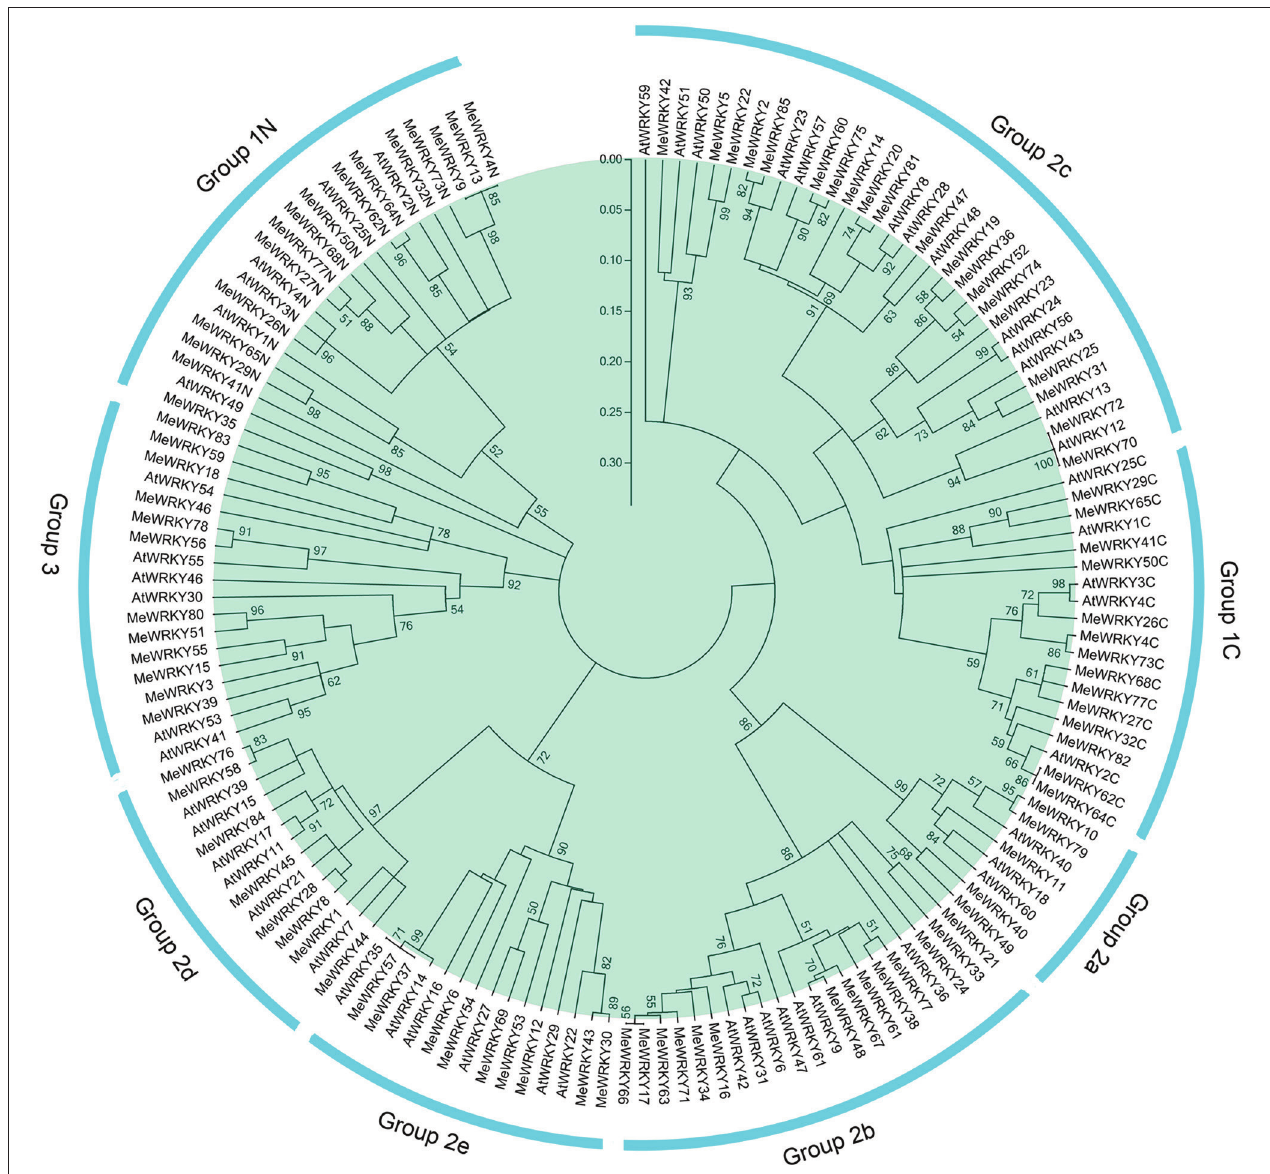
FIGURE 1 | Phylogenetic analysis of WRKY proteins from cassava and Arabidopsis. The NJ tree was constructed with WRKY domains of WRKYs from cassava and Arabidopsis using ClustalX 2.0 and MEGA5 with 1000 bootstrap. Branches with less than 50% bootstrap support were collapsed. The WRKY proteins are grouped into three groups (1–3) and five subgroups (2a–2e). Group 1 proteins with the suffix “N” or “C” indicates the N-terminal WRKY domains or the C-terminal WRKY domains. “AtWRKYs” are the WRKY proteins from Arabidopsis. “MeWRYKs” indicate the WRKY proteins from